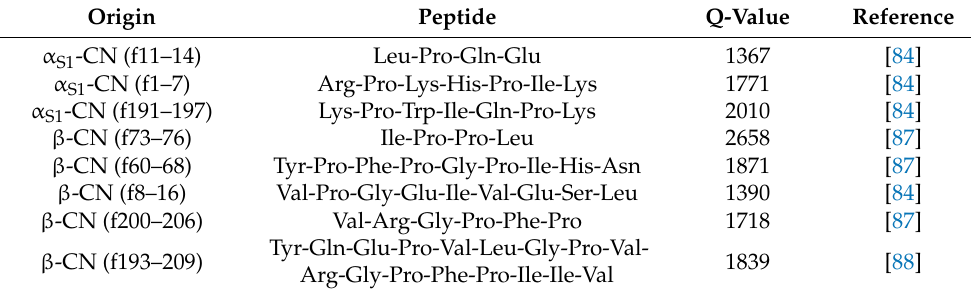
Table 3. Bitter peptides from Cheddar